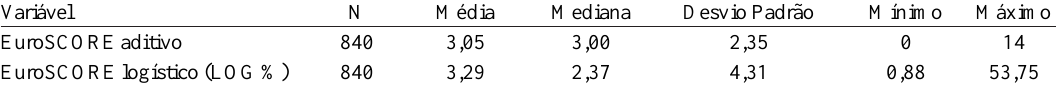
Tabela 4. Estatísticas descritivas do EuroSCORE dos pacientes analisados: variância.